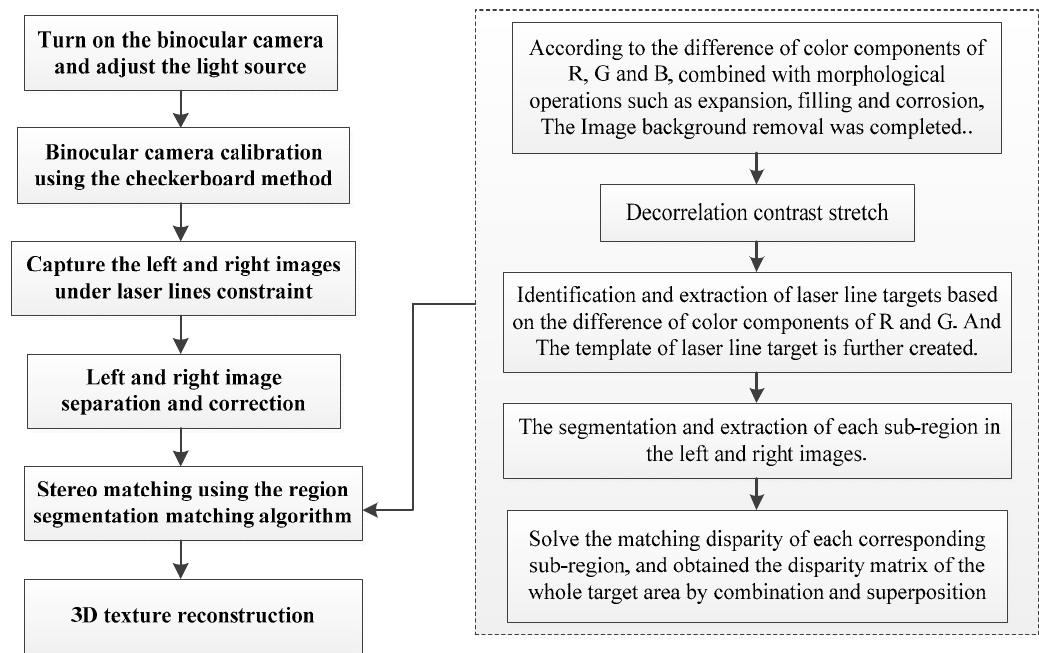
Figure 3. The test flow chart of the improved binocular reconstruction method.